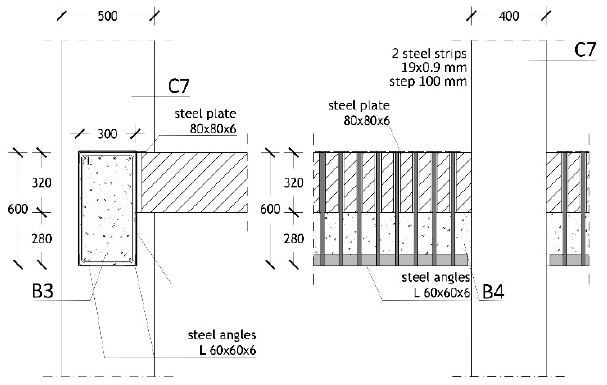
Figure 20. Full height ACM-strengthened beam.